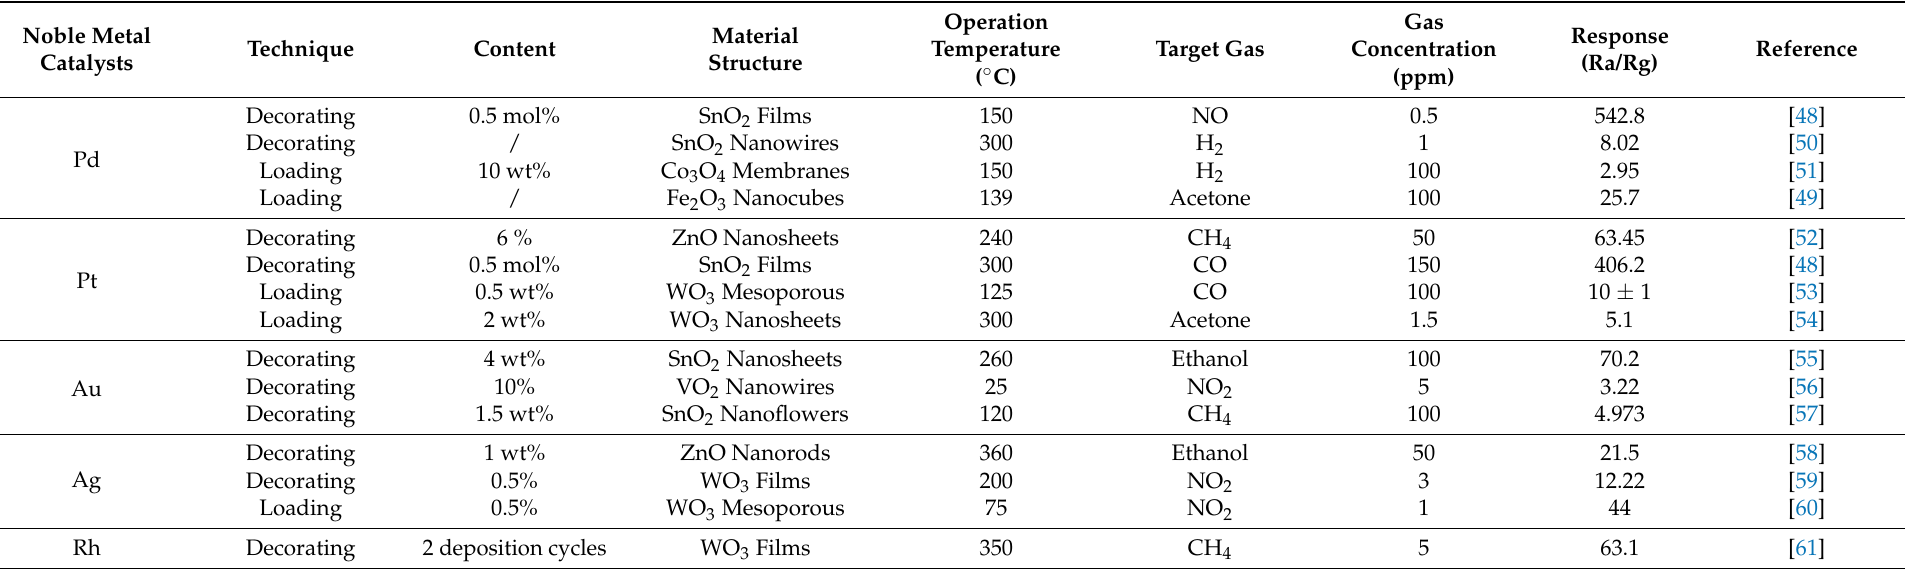
Table 1. Nanostructures decorated and loaded with noble metal